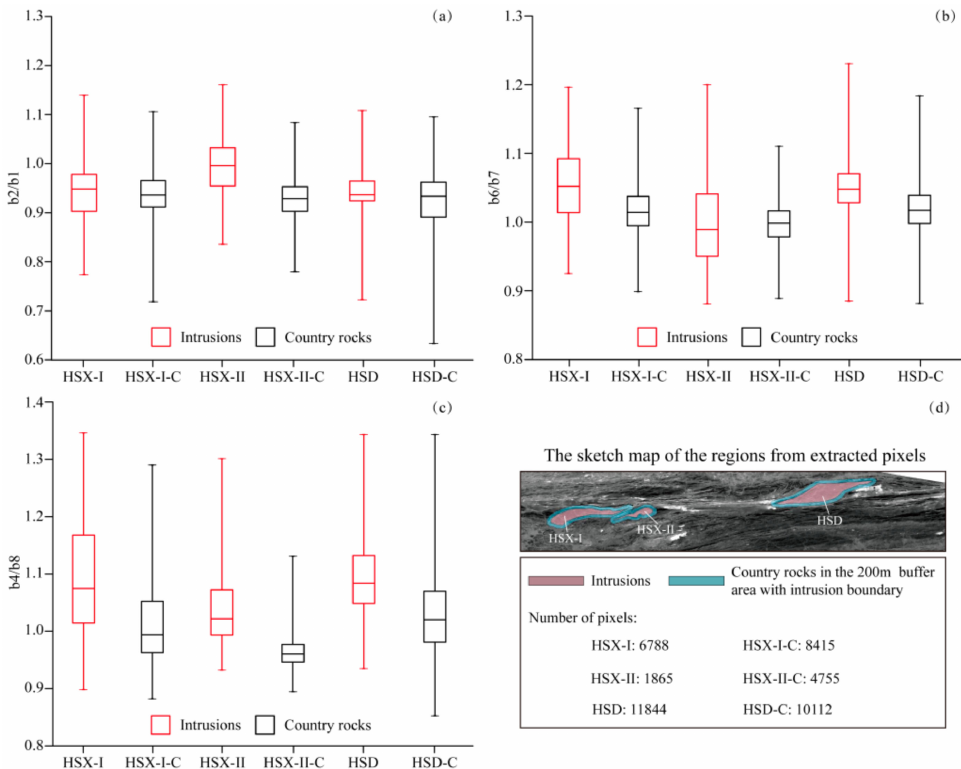
Figure 5. The quartile boxes of extracted pixels from the regions of HSX-I, HSX-II and HSD intrusions and their country rocks in the 200 m buffer area with intrusion boundary in the ASTER b2/b1 ( a ), b6/b7 ( b ), b4/b8 ( c ) images. The regions from extracted pixels in detail are shown in the sketch map, and number of pixels also are given ( d